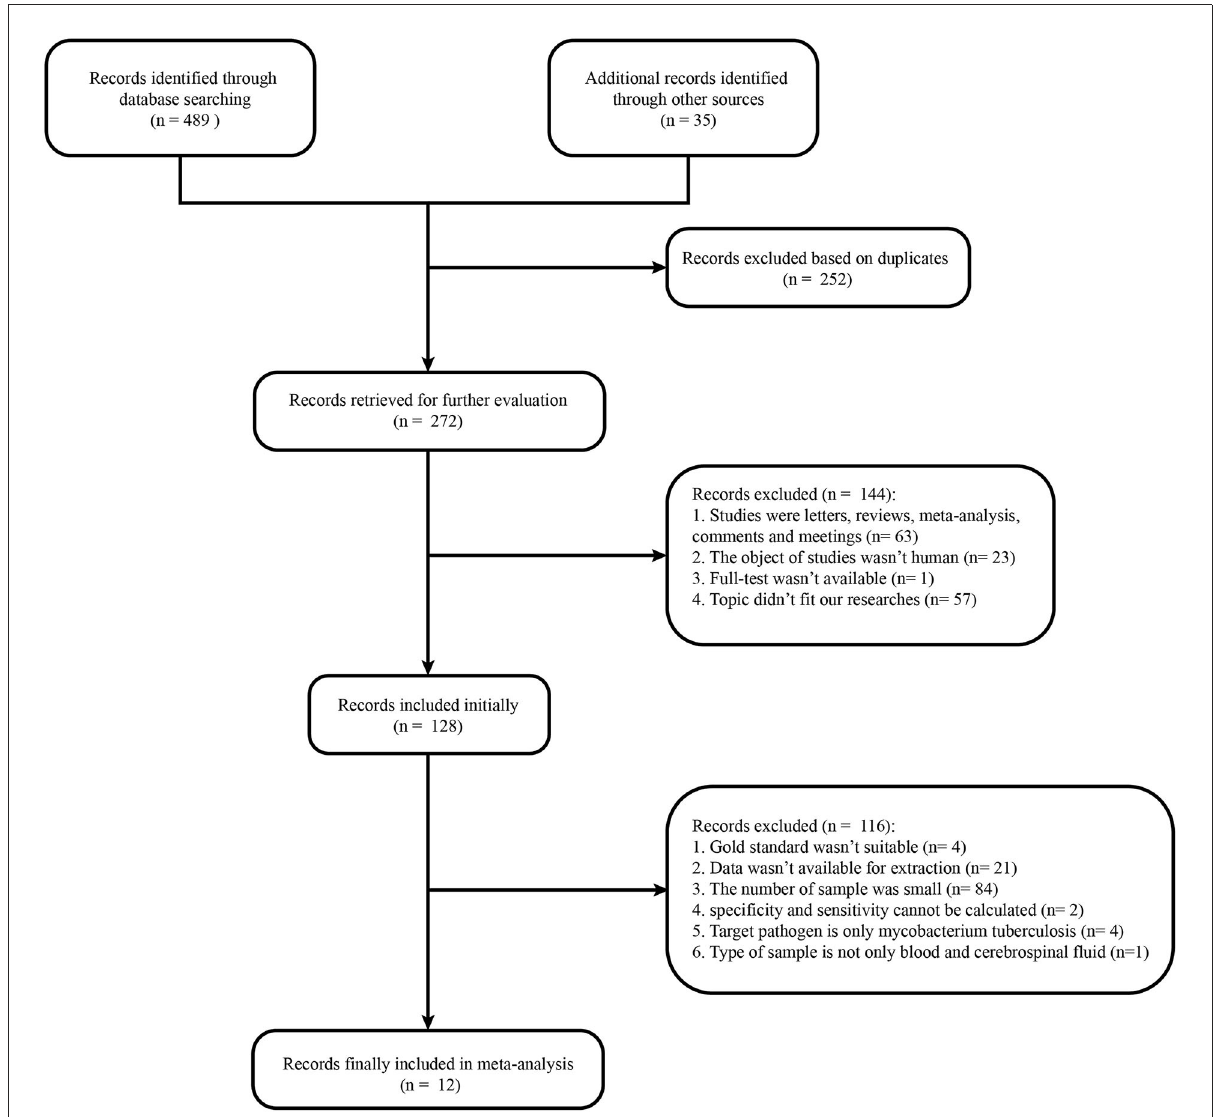
FIGURE1 Flow chart of literature retrieval. In total, 165, 0, 147, 177, 18, 12, and 5 articles were found in PubMed, Cochrane Library, Embase, Web of Science, ClinicalKey, Chinese Clinical Trial Registry, and Clinical Trials,